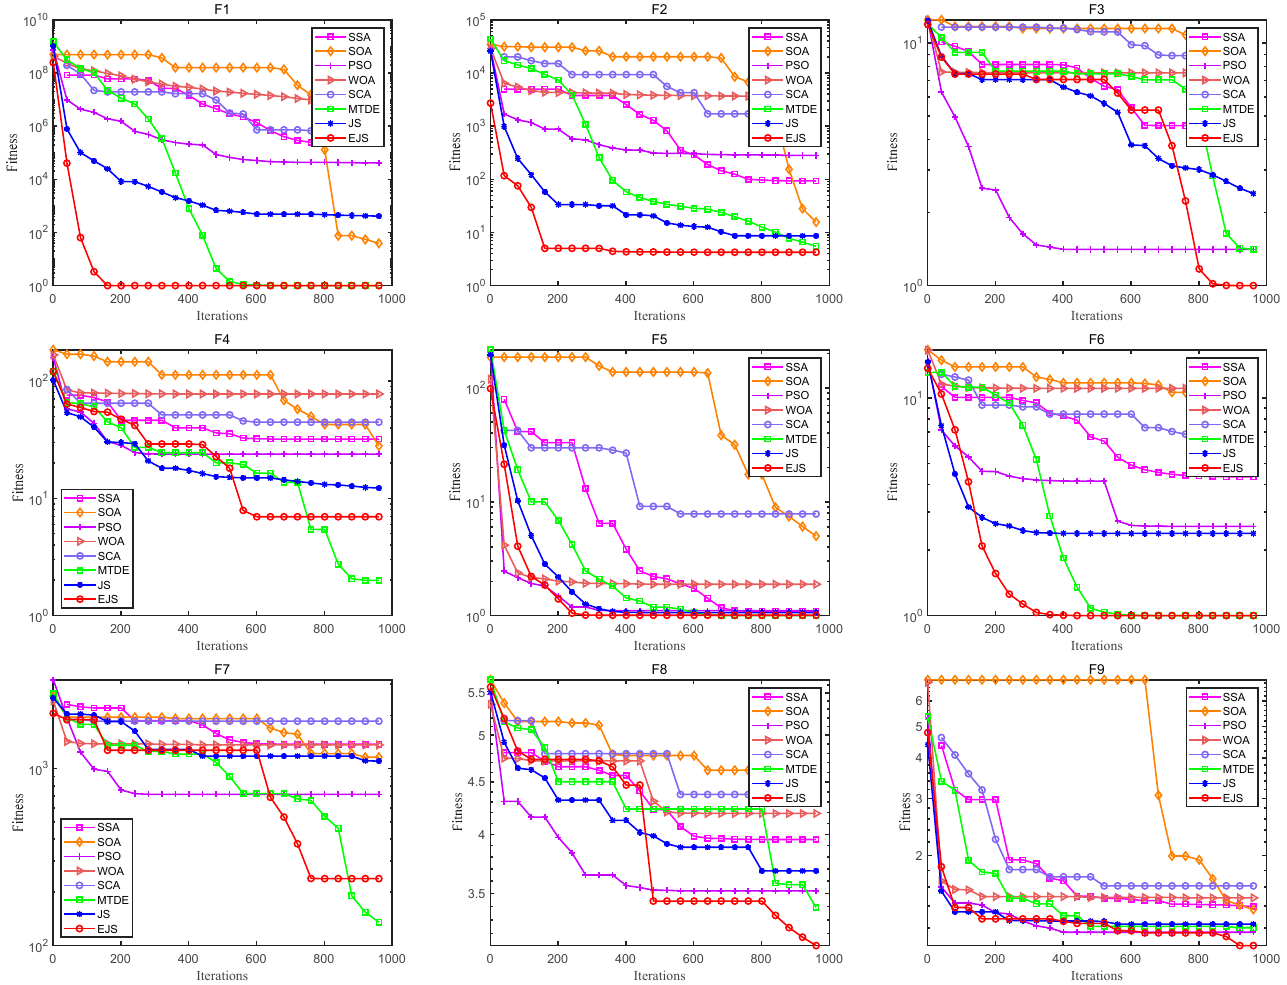
Figure 4. Convergence curves of all algorithms on the CEC2019 test set. The box plots can help researchers to understand and to explain the distribution characteristics obtained with all the algorithms’ solutions. The box plots of the EJS algorithm and the other eight optimization methods on the CEC2019 test set are shown in Figure 5. They show that the median of the EJS algorithm running 20 times is small, except for function tests F4 and F7, which verifies the superiority and effectiveness of the EJS algorithm. At the same time, the rectangular area of the EJS algorithm is clearly narrower than the other methods on function tests F1~F3, F5, and F6, which illustrates that the EJS algorithm has strong stability. The approximate solution can be obtained on almost all time runs. In addition, the height between the upper and the lower quartile is low, indicating that the solution of the EJS algorithm has high consistency. In terms of the EJS algorithm outliers, function test F3, F8, and F9 have fewer outliers, which shows that the EJS algorithm avoids the existence of contingency, and the solution obtained in each iteration is slightly affected by the random strategy. In general, the EJS algorithm is more stable and more accurate than the other compared